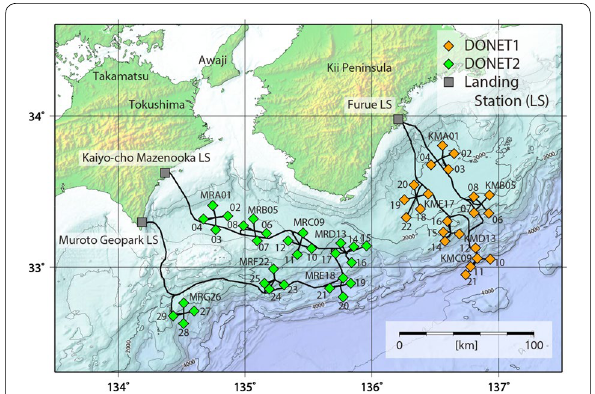
Terminal unit (TU)